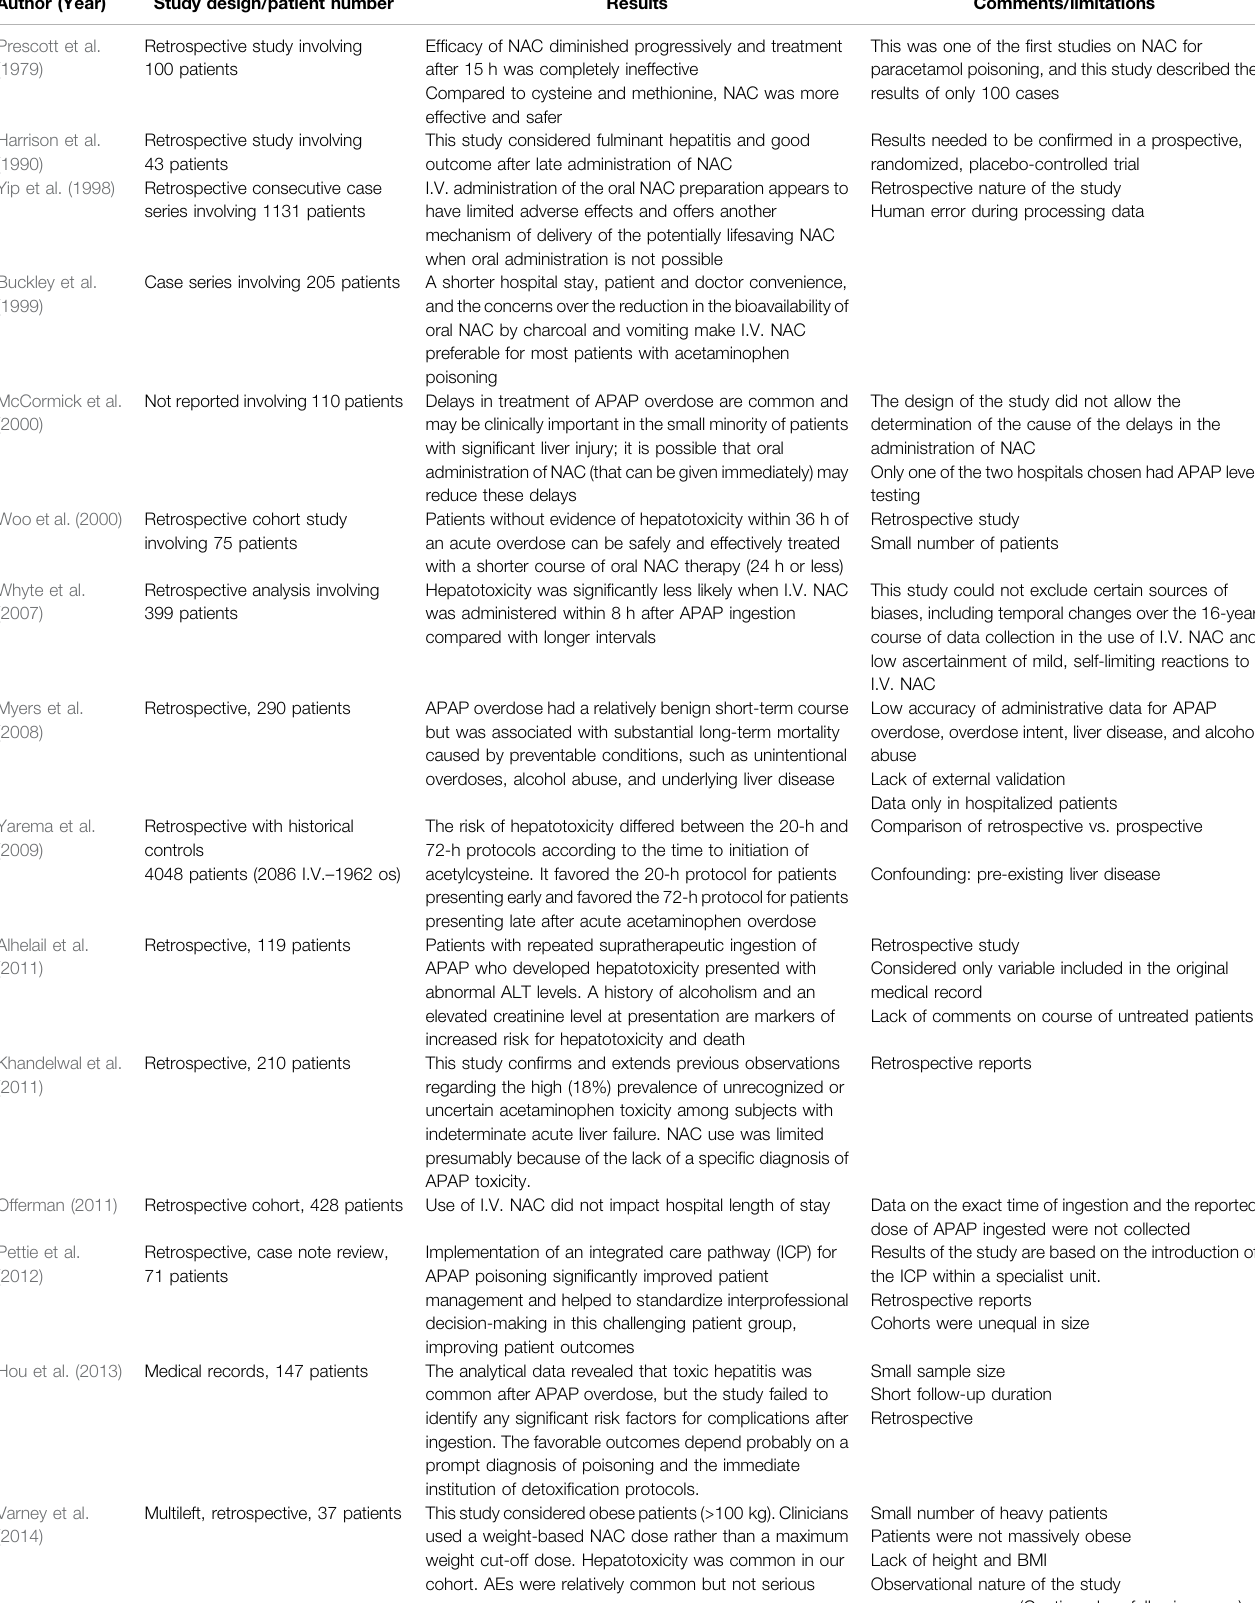
TABLE 4 | | Heterogeneity and quality assessment of 18 retrospective studies included in the